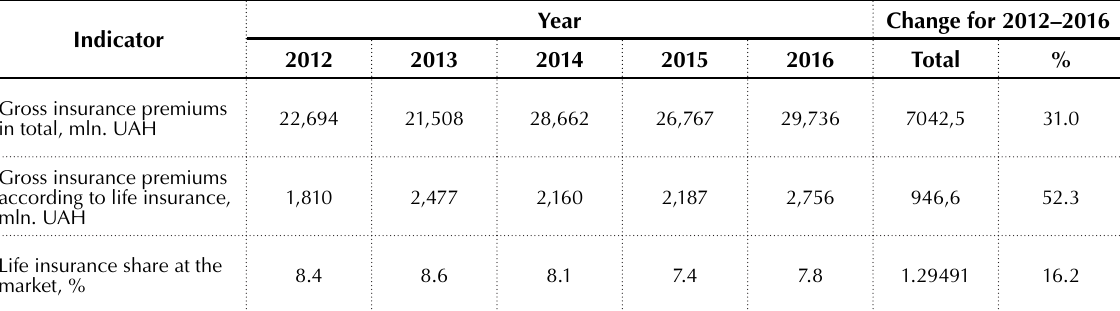
Table 1. Life insurance at the Ukrainian insurance market in 2012–2016